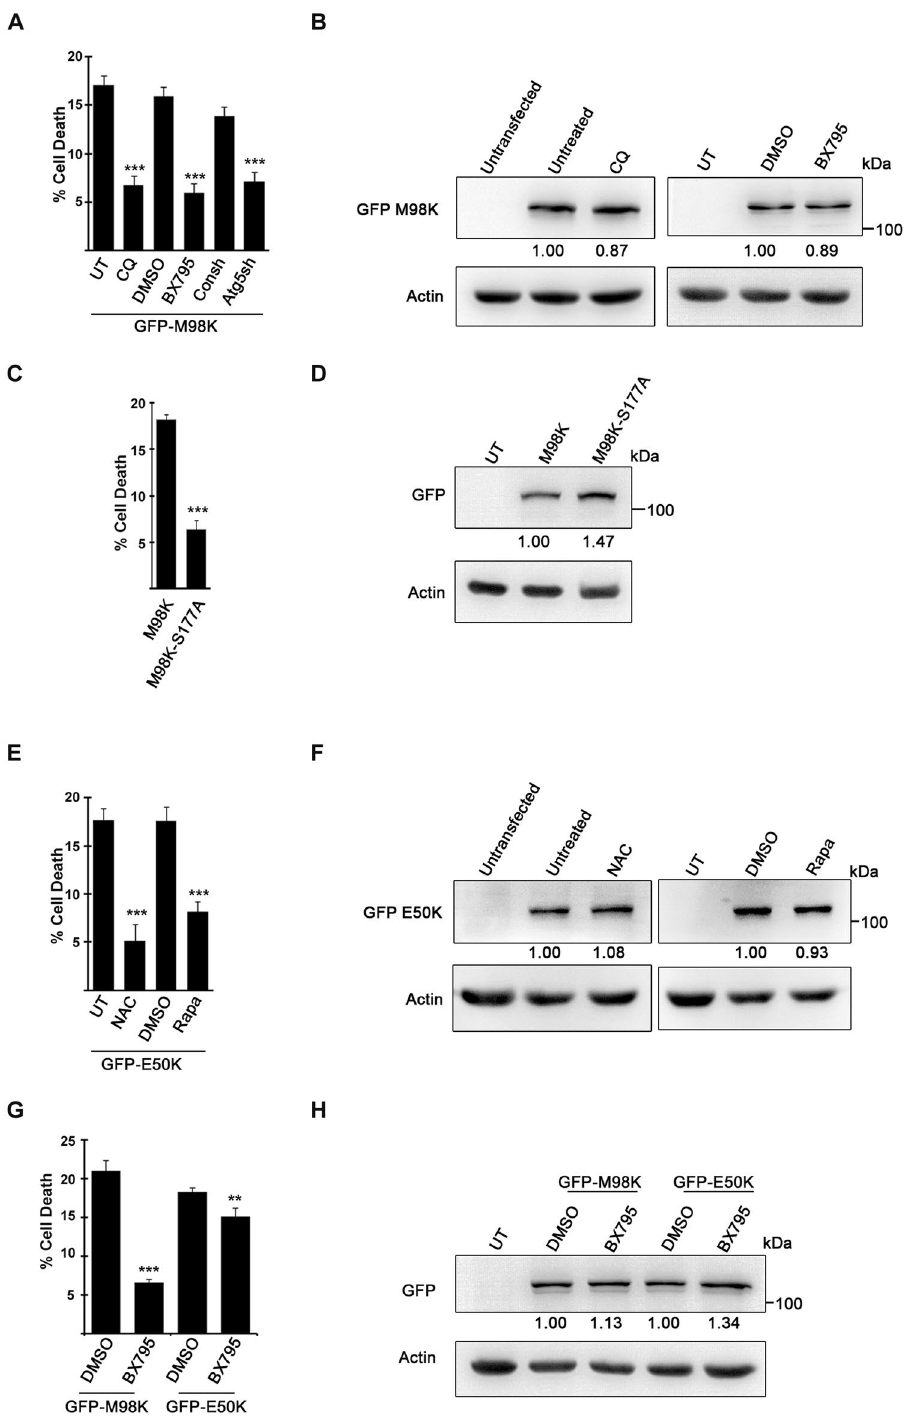
Figure 6. Mechanism of M98K-OPTN and E50K-OPTN induced cell death in 661W cells. ( A ) Effect of various inhibitors and Atg5 knockdown on M98K-OPTN induced cell death. 661W cells transfected with GFP-M98K were treated with CQ (25 µ M) or BX795 (1 µ M) after 14 hours of transfection for 18 hours along with indicated controls and cell death was quantified based on Annexin V/7AAD positivity. 661W cells were cotransfected with GFP-M98K and control shRNA or Atg5 shRNA and cell death was determined after 32 hours. ( C ) Effect of mutation of Ser177 to Ala in M98K-OPTN on induction of cell death in 661W cells. ( E ) Effect of antioxidant NAC and autophagy inducer rapamycin on E50K induced cell death. 661W cells were transfected with GFP-E50K. After 6 hours of transfection, cells were either treated with NAC (5 mM) for 26 hours or left untreated. GFP E50K transfected cells were treated with DMSO vehicle or rapamycin (1 µ M) after 14 hours of transfection for 18 hours and cell death was quantified. ( G ) Effect of Tbk1 inhibitor on E50K-OPTN induced cell death. Treatment with BX795 (1 µ M) was done as described for panel A. ( A , C , E , G ) Cell death data shown in bar diagrams represent mean ± s.d. of percentage of GFP expressing cells showing Annexin V/7-AAD (Anx. V/7-AAD) staining